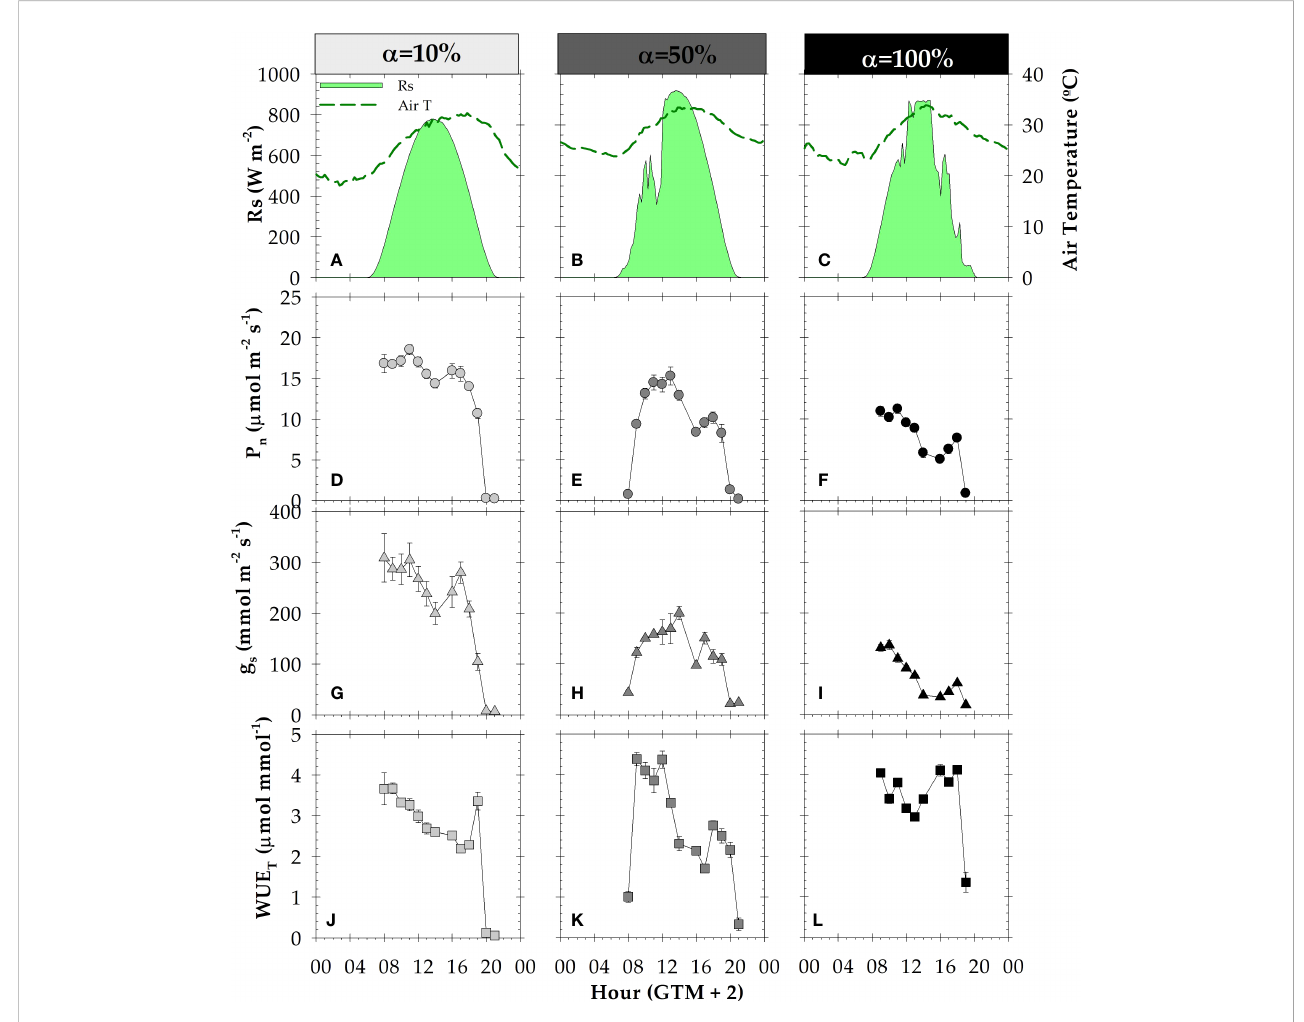
FIGURE 9 Daily courses of: (A – C) solar radiation (R s ) and air temperature; (D – F) net photosynthesis (P n ); (G – I) stomatal conductance (g s ); (J – L) transpiration ef fi ciency (WUE T ), during different irrigation criteria: a =10% (DOY 174), a =50% (DOY 210) and a =100% (DOY 244). Each point is the mean of four leaves. Vertical bars in data points are ± SE (not shown when smaller than the symbols). GMT: Greenwich mean